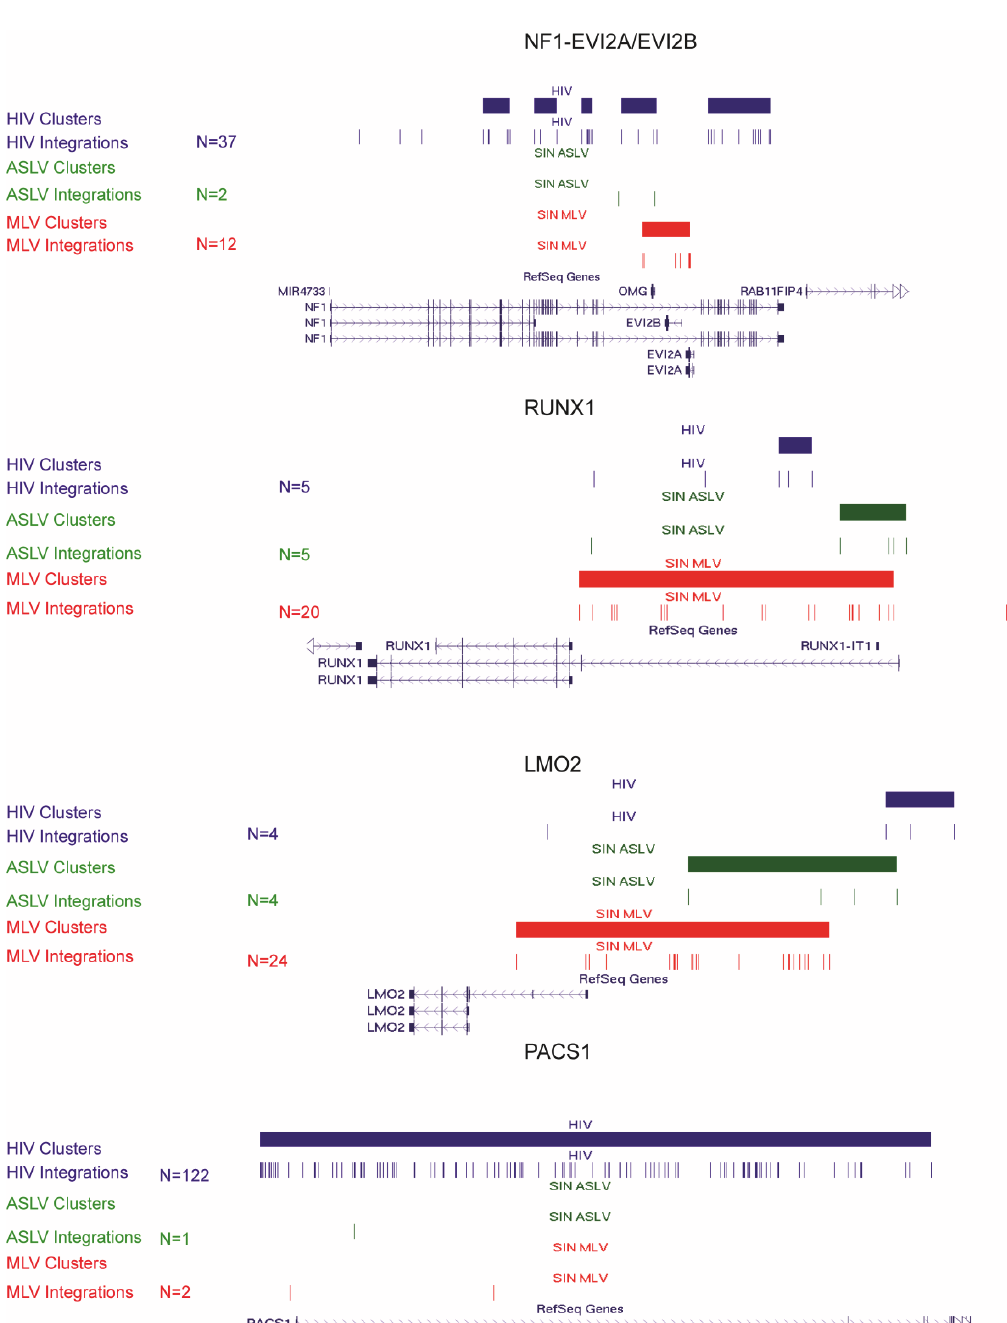
Figure 3. SIN-MLV, SIN-ASLV and SIN-HIV integration sites and clusters in CD34 + HSPC-specific loci. Distribution of SIN-MLV (red), SIN-ASLV (green) and SIN-HIV (blue) integration clusters (horizontal solid bars) and integrations (vertical marks) in the NF1-EVI2A/B, RUNX1, LMO2 and PACS1 loci, as displayed by the UCSC Genome